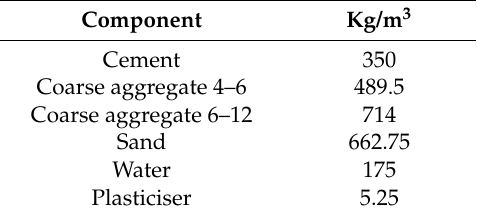
Table 2. Dosage used for the preparation of concrete.